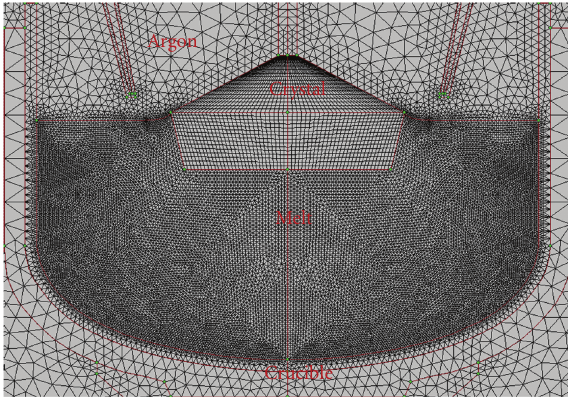
Figure 2: Distribution of the control volumes inside the